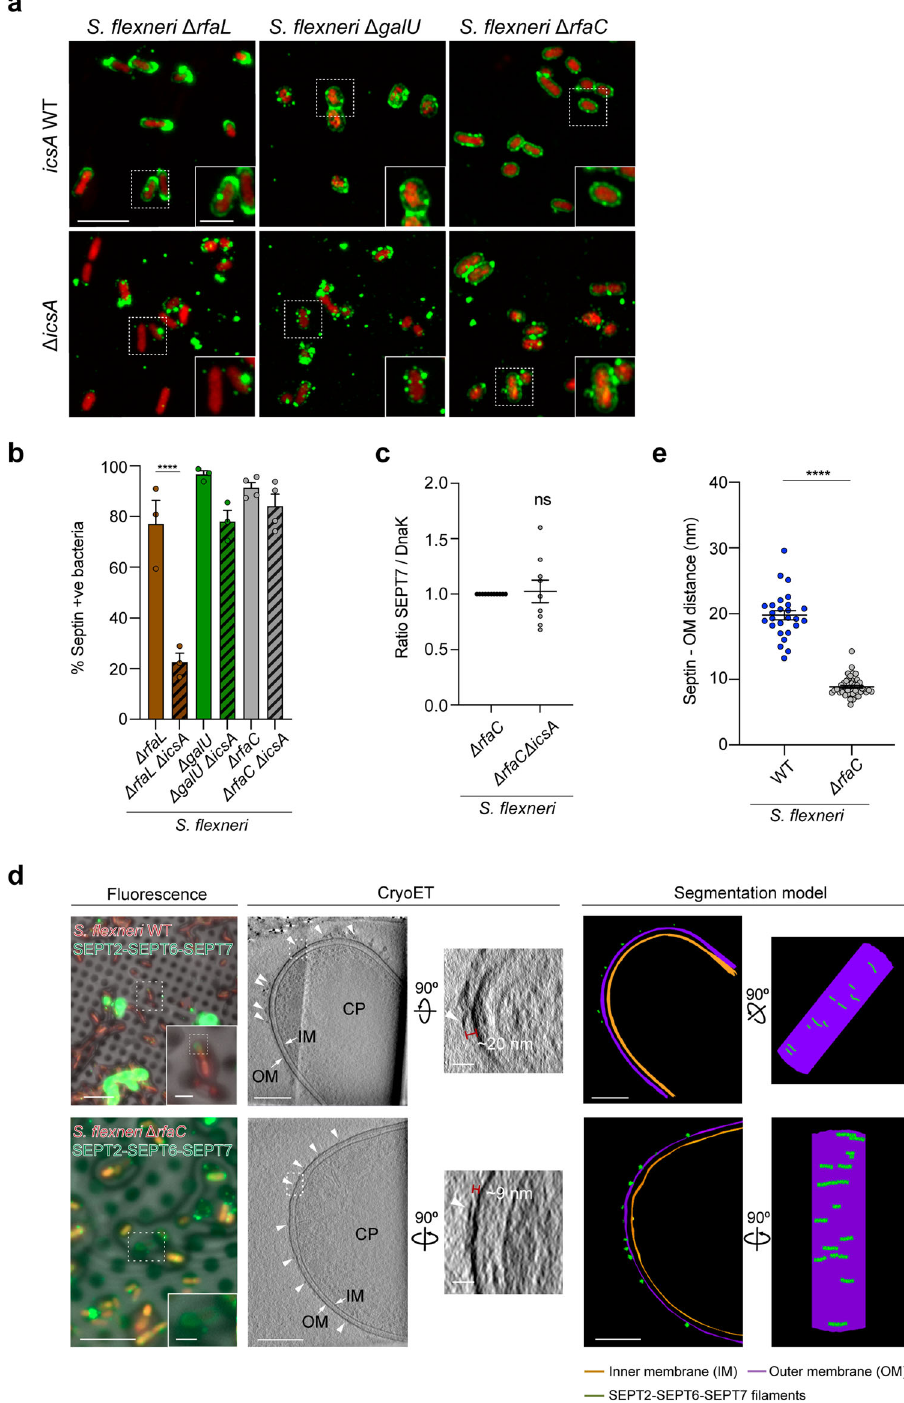
Fig. 6 IcsA disrupts lipopolysaccharide and promotes septin recognition of S. fl exneri . a Airyscan confocal images comparing septin binding in the presence (top) or absence (bottom) of IcsA to S. fl exneri Δ rfaC , Δ rfaL, and Δ galU . Scale bar, 5 μ m. b Percentage of bacteria recruiting septins in vitro. Quanti fi cations represent mean ± SEM from n = 1022 ( Δ rfaC ), n = 1072 ( Δ rfaC Δ icsA ), n = 594 ( Δ rfaL ), n = 605 ( Δ rfaL Δ icsA ), n = 653 ( Δ galU ) and n = 761 ( Δ galU Δ icsA ) S. fl exneri cells distributed in 3 independent experiments. **** p < 0.0001 by one-way ANOVA and Tukey ’ s post-test. c Bacterial sedimentation assays of samples from panel ( a ). Data represent mean ± SEM from 4 independent blots. ns, p = 0.665 by two-tailed Mann – Whitney ’ s test. d Representative correlative cryo-light microscopy and cryo-ET images of S. fl exneri WT (top, accession No. #EMD-12571) or Δ rfaC (bottom, accession No. #EMD-12579) showing bound septins in vitro (arrowheads and green segmentation). Images shown correspond to a slice of 10.8-nm thickness ( S. fl exneri WT) and a slice of 11.0-nm thickness ( S. fl exneri Δ rfaC ). CP, cytoplasm; OM, outer membrane; IM, inner membrane. This experiment was performed 2 independent times. Scale bars, fl uorescence microscopy, 10 μ m (inset, 2 μ m), cryoET, 200 nm (inset, 50 nm). e Measured distance between septin fi laments and the S. fl exneri outer membrane. Data correspond to mean ± SEM from n = 26 ( S. fl exneri WT) and n = 46 ( S. fl exneri Δ rfaC ) fi laments from 3 independent tomograms. **** p < 0.0001 by two-tailed Student ’ s t